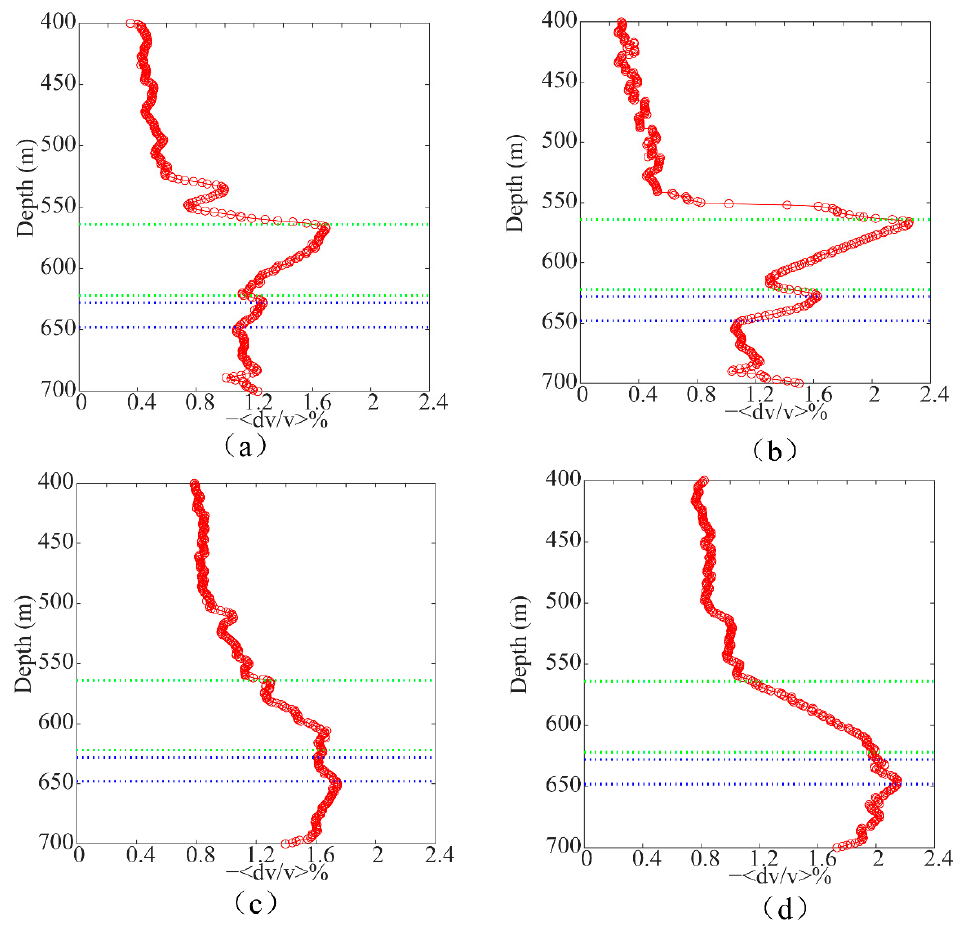
Figure 10. The estimated mean velocity change versus the receiver depth from the baseline survey and second-repeat survey using ( a ) CWI processing of the upgoing waves of the vertical component, ( b ) CWI processing of the upgoing waves of the horizontal component, ( c ) CWI processing of the downgoing waves of the vertical component, and ( d ) CWI processing of the downgoing waves of the horizontal component. The CO 2 injection layer is indicated by blue dotted lines and the CO 2 leakage layer is indicated by green dotted lines.